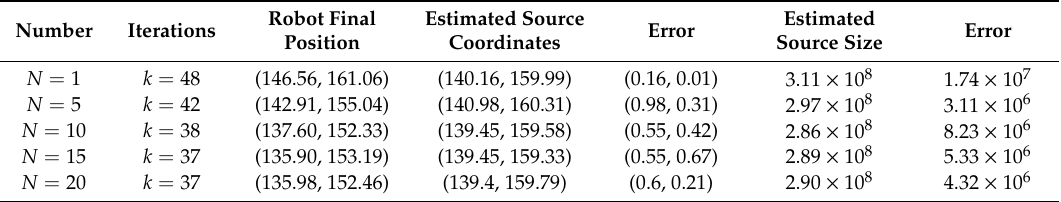
Table 1. Error of radioactive source estimation under di ff erent measurement